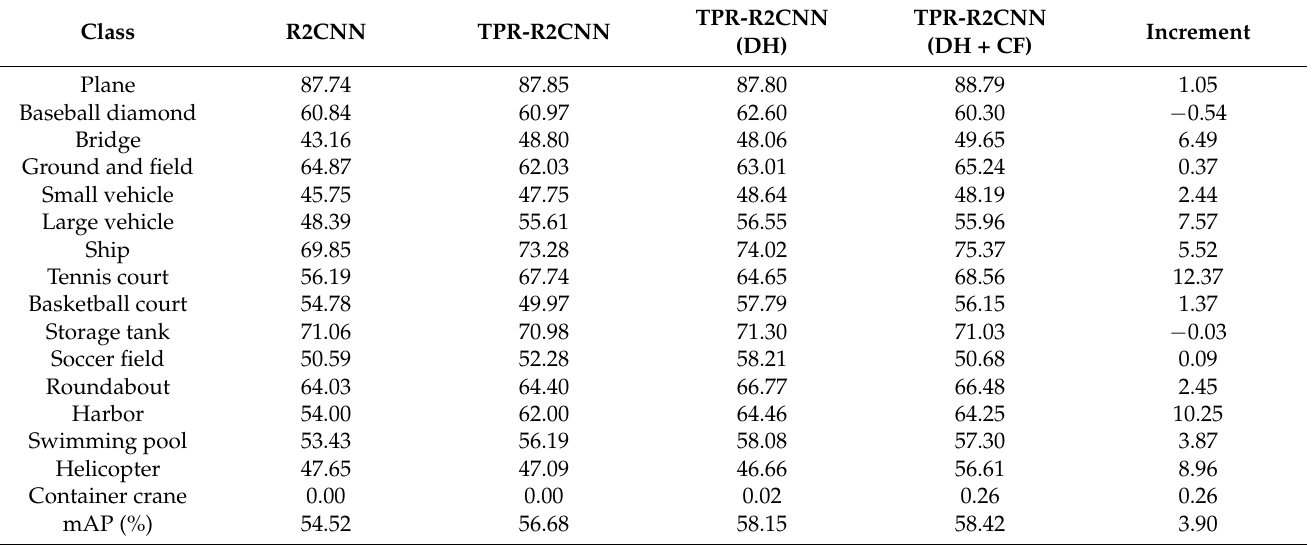
Table 5. Comparison of the AP (%) of each class for the DOTA-v1.5 dataset. DH: Double detection head; CF: classification fusion.